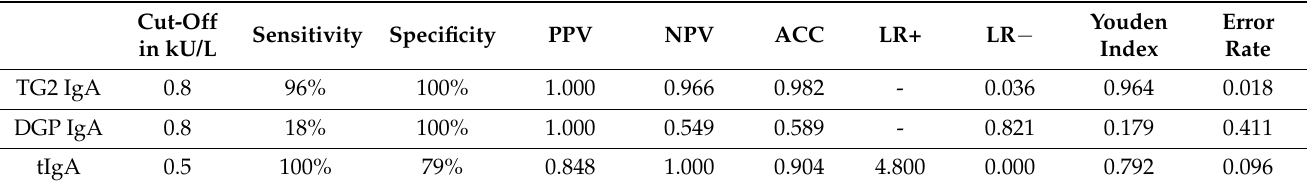
Table 3. The diagnostic assessment of simultaneous detection of celiac specific antibodies and